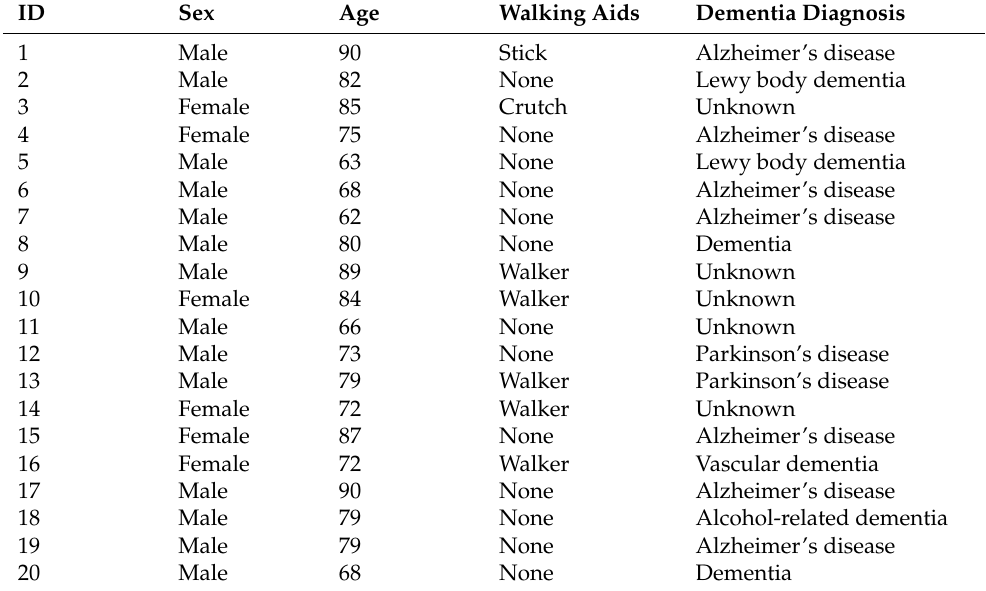
Table 1. An overview of the dataset used in this